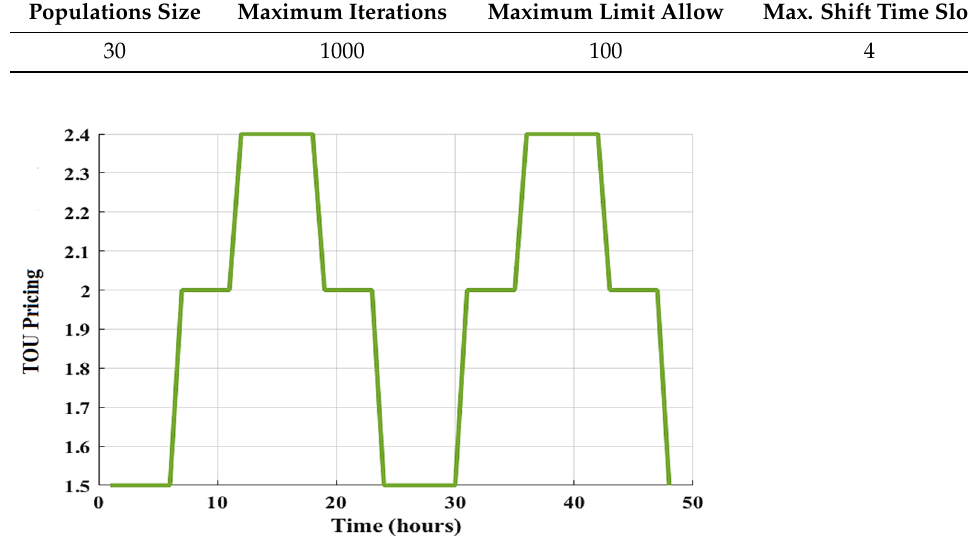
Table 3. CSO, SSA, and BOSA control parameters.